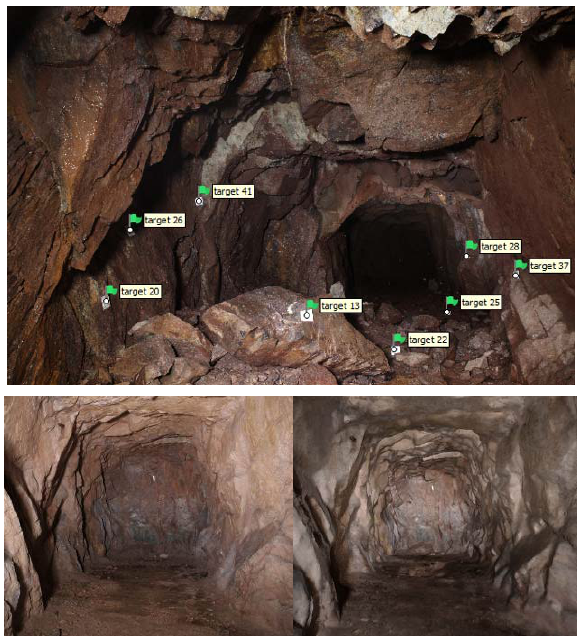
Figure 13 : (a) Image of gallery #3 with targets, (b) Image and extract of 3D model of gallery